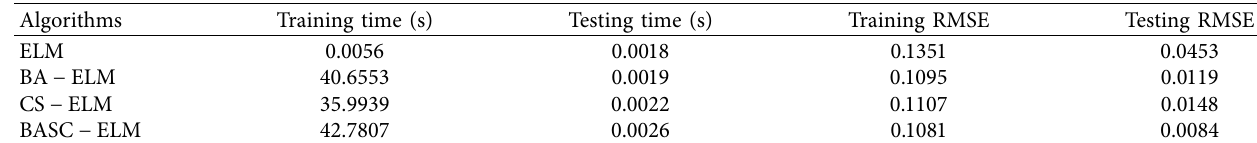
Figure 2: Comparison of the fitting effects of the four algorithms: (a) ELM, (b) BA − ELM, (c) CS − ELM, and (d) BACS − ELM. Table 5: The performance comparison of four algorithms on Sinc